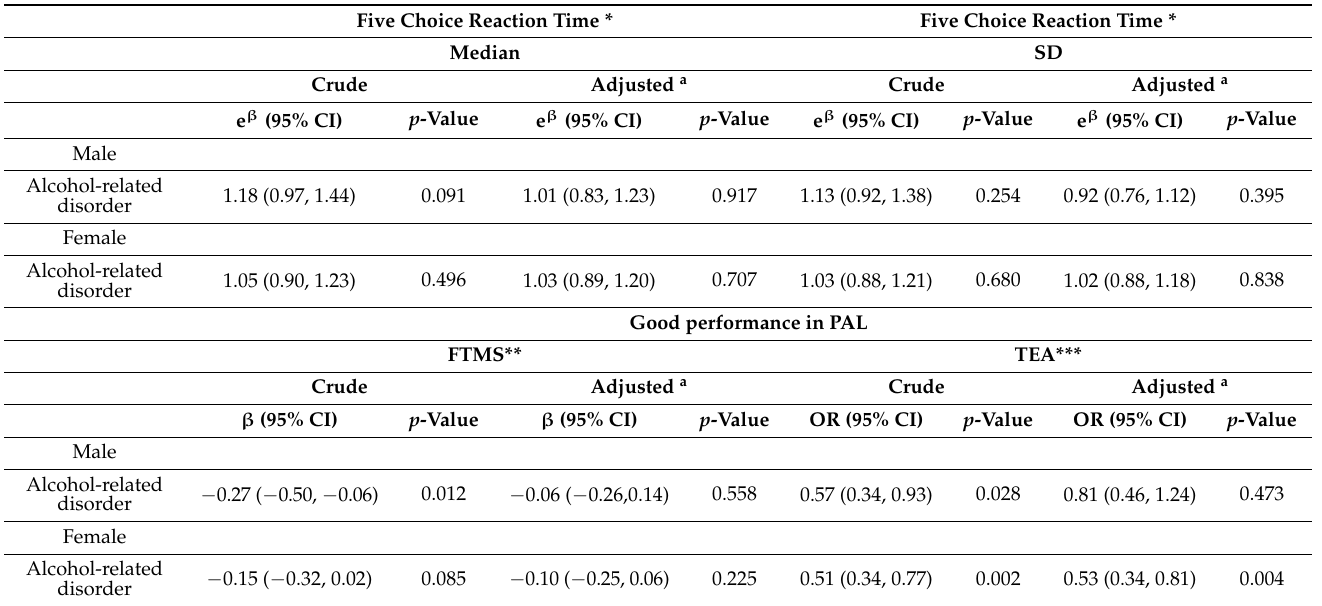
Table 3. Association of reaction time and visual memory with alcohol-related disorder in bipolar disorder. Five Choice Reaction Time